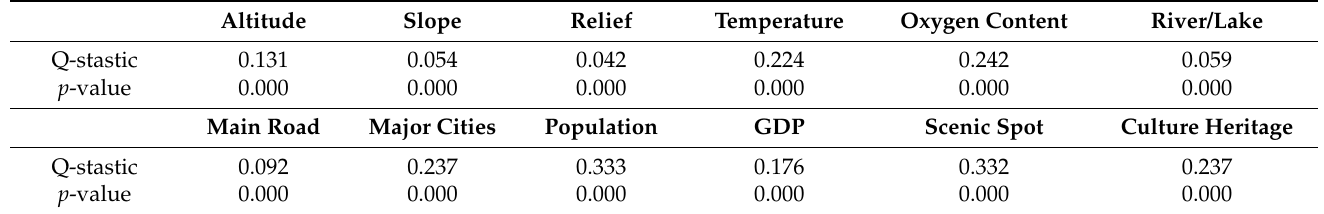
Table 3. Geographical detection results of factors influencing the spatial distribution of RT